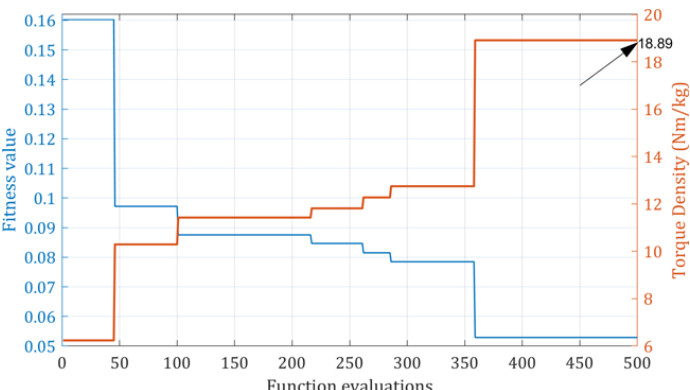
Figure 16. Objective function (torque density) and its inverse (fitness function) variation through the evolution of the optimization